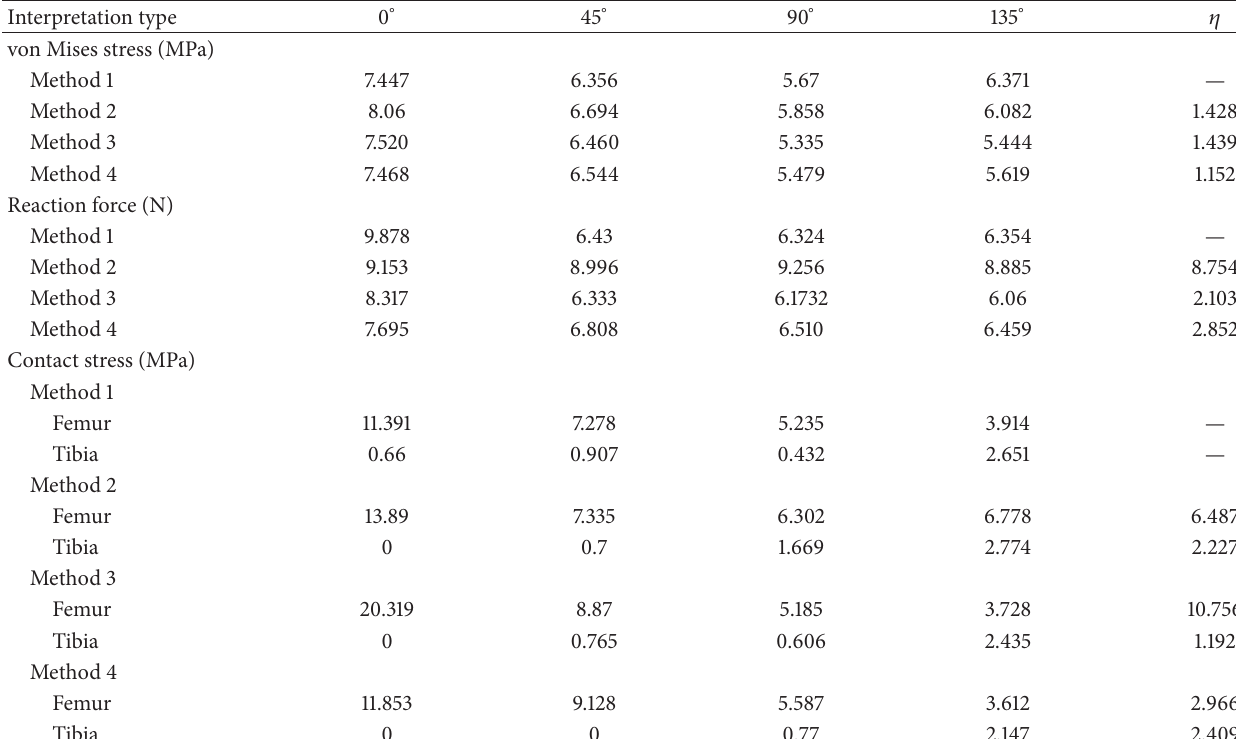
Table 1: Error rates between Method 1 and Methods 2, 3, and